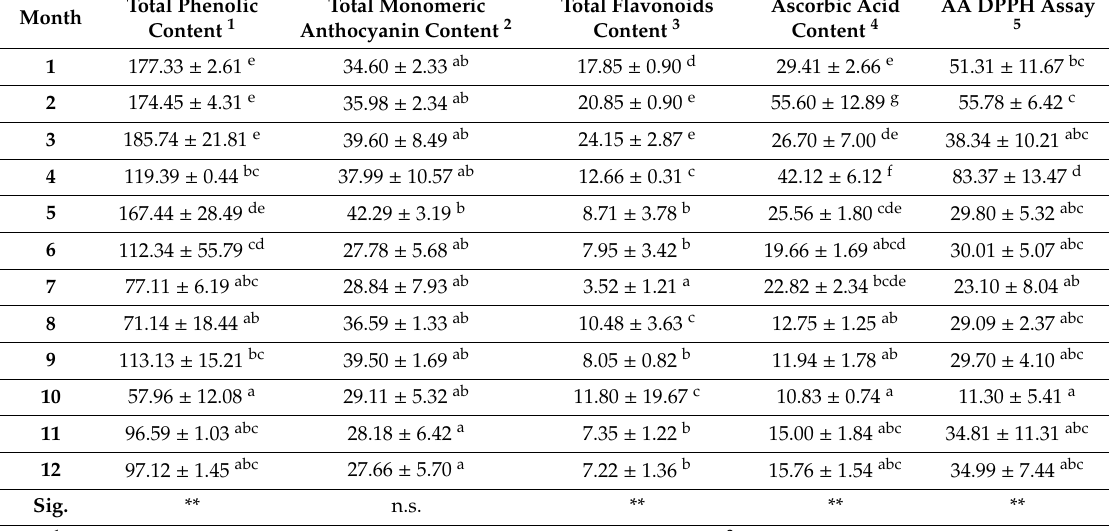
total phenolic content, total monomeric anthocyanin content, total flavonoid content, the ascorbic acid content, and the antioxidant activity DPPH assay parameters in red raspberries (cv. Erika). The results are the mean of three replicates ± Standard Deviation. ** ( P ≤ 0.01); n.s. (not significant). The letters represent the significant di ff erence vertically at P ≤